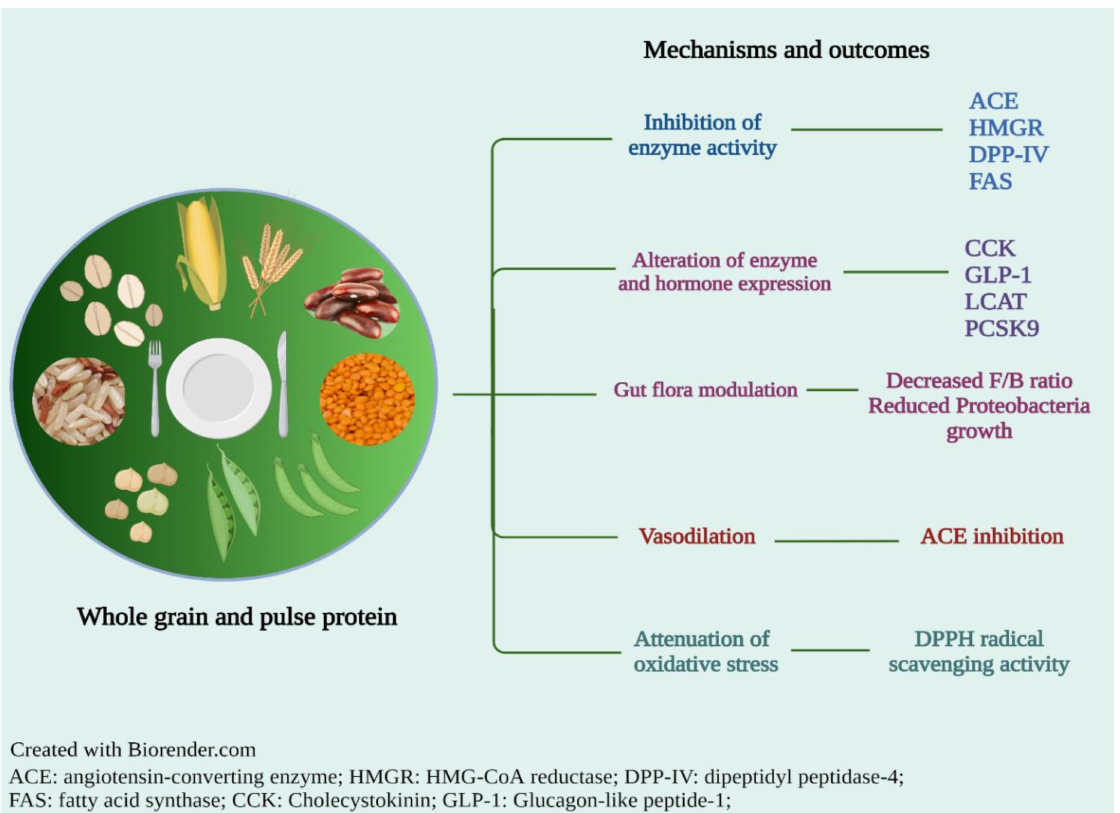
Figure 1. The mechanistic actions and outcomes of cereal grain- and pulse-derived proteins to promote good